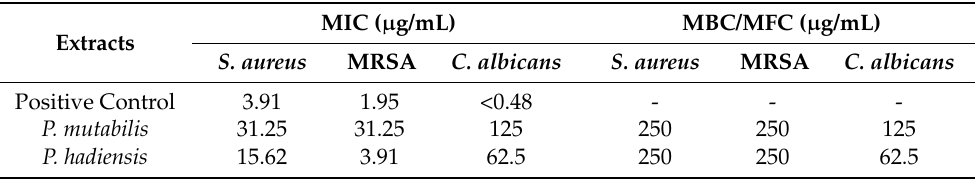
Table 2. MIC and MBC/MFC ( µ g/mL) values of the most active acetonic extracts. MIC ( µ g/mL) Extracts